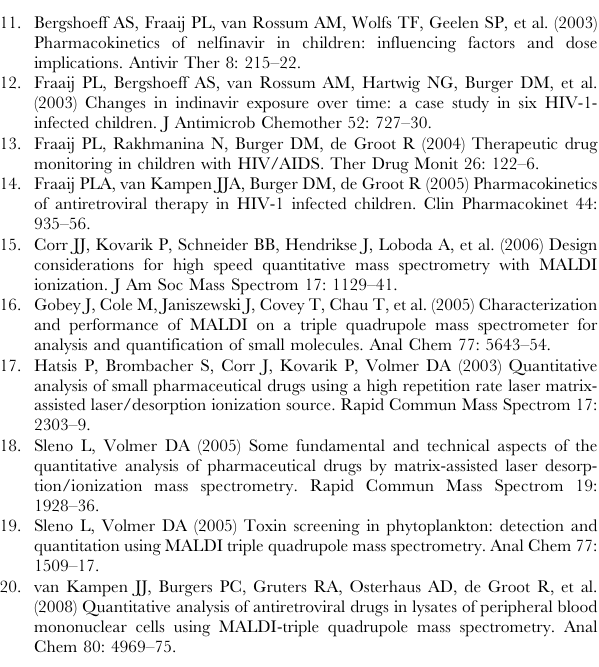
Table S1 Quantitative analysis of HIV protease inhibitors in plasma. The first column shows the specific drug and the second column shows the concentration of the drug spiked in plasma in m M. The third column shows the actual amount of drug in femtomoles (fmol) in a single spot on the target plate. The fourth column shows the accuracies, expressed as % deviation, for samples used to construct the calibration curve (calibrators), and the fifth column show the accuracies for samples used to test the validity of the calibration curve (quality controls). Precisions, expressed as %CV, are reported between brackets (n= 9 spots on the target plate). For the analysis of lopinavir and ritonavir, quality controls were spiked with carbamazepine, metoprolol, metroni- dazol, amoxicillin, piroxicam, nevirapine, saquinavir, efavirenz, indinavir, and tipranavir at a plasma concentration of 10 m M each. For analysis of nelfinavir, saquinavir, and indinavir, quality controls were spiked with efavirenz, tipranavir, lopinavir, ritona- vir, carbamazepine, metoprolol, metronidazol, amoxicillin, priox- icam, and nevirapine at a plasma concentration of 10 m M each. These drugs were not added to the calibrators. The calibrators were prepared in plasma from a different healthy donor than the quality controls were.